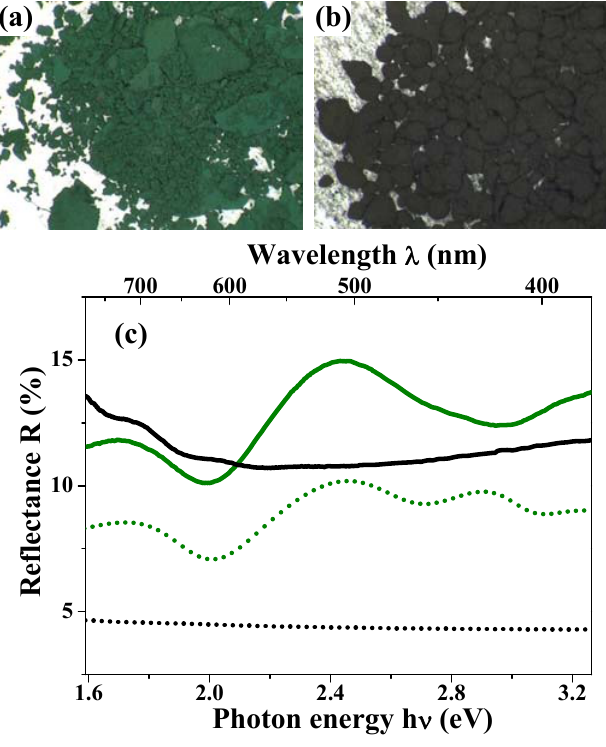
Figure 11. (a) and (b) are photographs of the hollow and dense particles, respectively; (c) Diffuse reflectance spectra for the magnetite hollow spheres (green solid curve) and the dense particles (black solid curve). The calculated reflectance spectra based on the theory of Mie scattering for the hollow spheres (green dotted curve) and the dense particles (black dotted curve) reproduce the peak positions of the experimental data. The absolute experimental values are typically not reproduced by the calculations, due to the approximation of the Kubelka-Munk